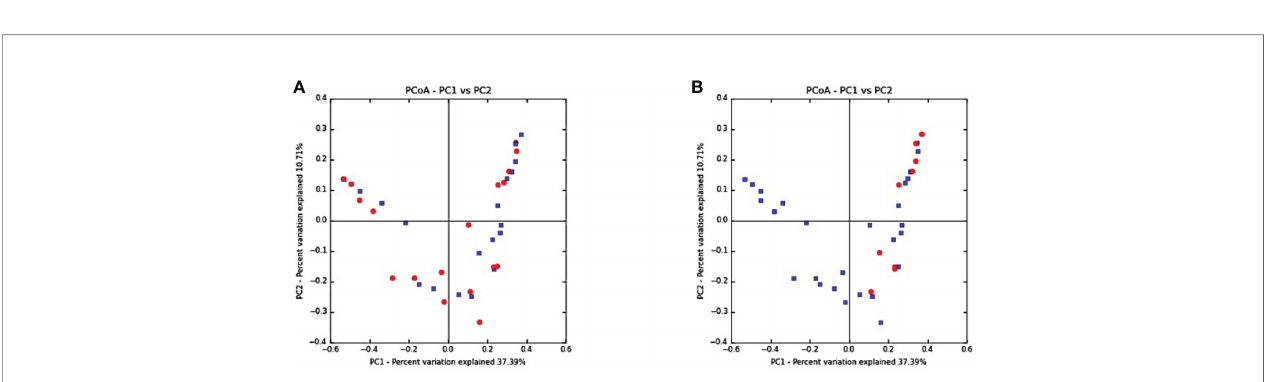
FIGURE 3 | Beta diversity: principal coordinate analysis (PCoA) with Unifrac distance matrices. (A) Healthy peri-implant sites (blue) vs. peri-implantitis (red). (B) Bleeding on probing (BoP) <10% showing clustering toward the upper and lower quadrants (BoP <10% in red and BoP >10% in blue) in groups with peri-implantitis and those with healthy peri-implant